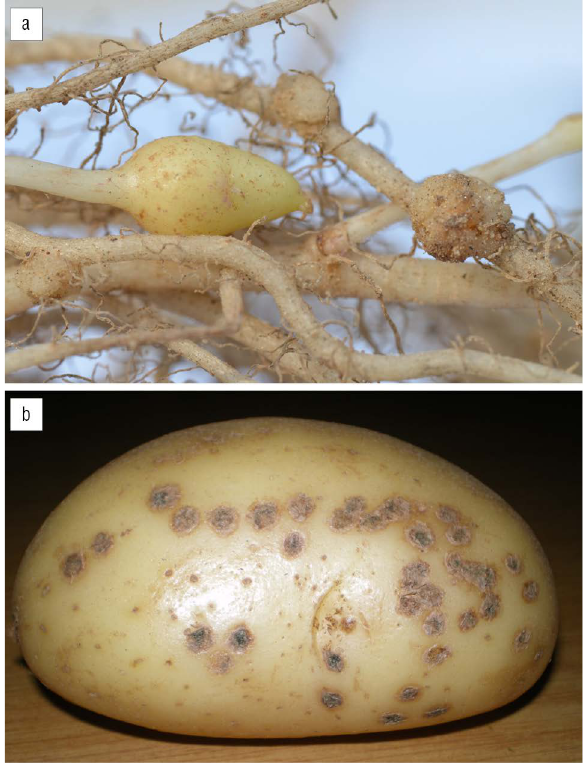
(a) Root galls on potato roots. (b) Powdery scab on a potato tuber. Zebra chip